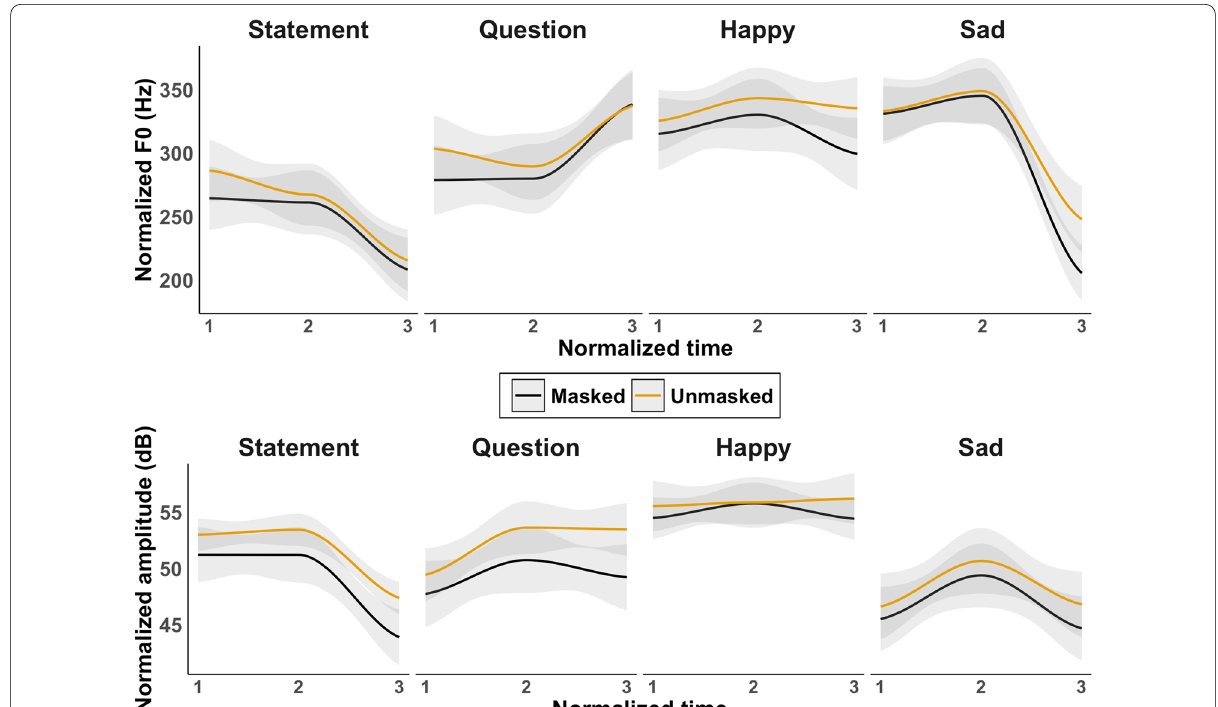
Fig. 1 Normalized F 0 (top) and amplitude (bottom) over three normalized time points. Solid lines represent a smoothed best fit with gray 95% confidence